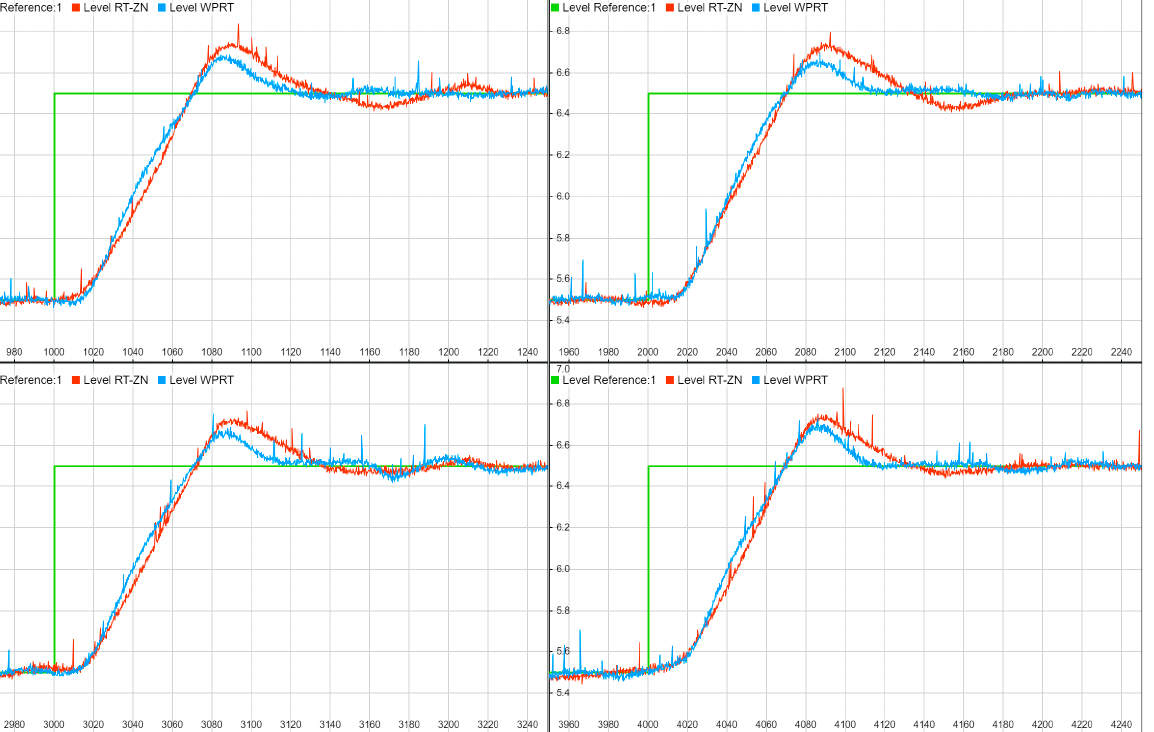
Figure 11. Process input disturbance test: The controller’s output, the setpoint flow rate of the feed water for the slave controller, was increased by 10 kg/s. Water-level setpoint (green), RT-ZN tuning (red), proposed WPRT method (blue).